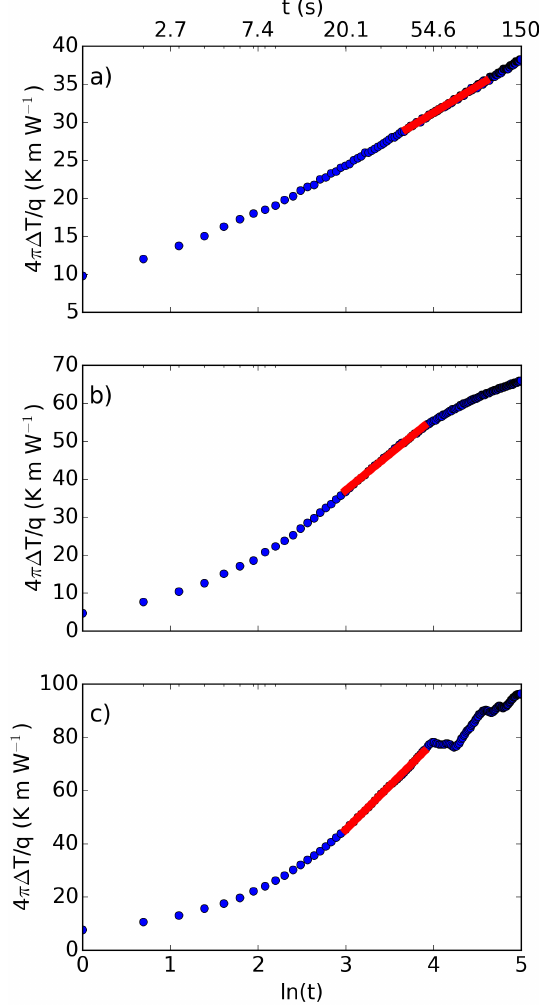
Figure 2. Heating plots obtained with the needle probes of Fig. 1. Red lines show the fit using the selected time range. (a) Heating plot obtained on 22 February 2013 with the NP at a height of 44 cm. After an initial period of less than 20s when steady state does not apply, the plot is linear. Time range used: 40–100s. (b) Plot of 22 February 2013 with the NP at 34cm. The lower slope at long heating times is indicative of convection. Time range used: 20–50s. (c) Plot of 5 April 2013 with the needle probe at 14cm. k eff was 0.037Wm − 1 K − 1 and (cid:49)T max was 3.5 ◦ C, triggering intense and unstable convection. Time range used: